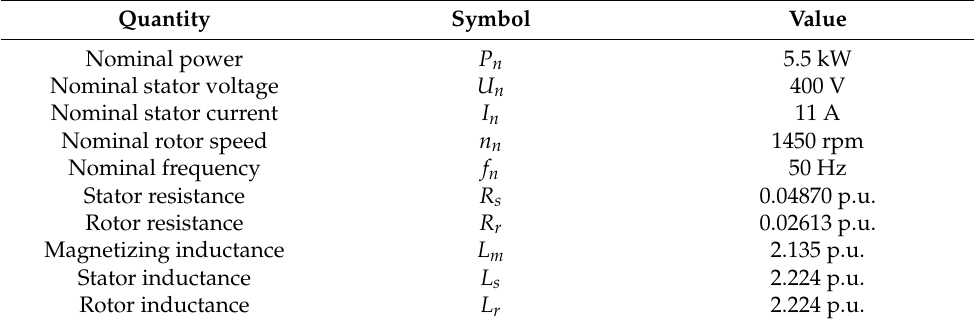
Table A1. Induction machine parameters.